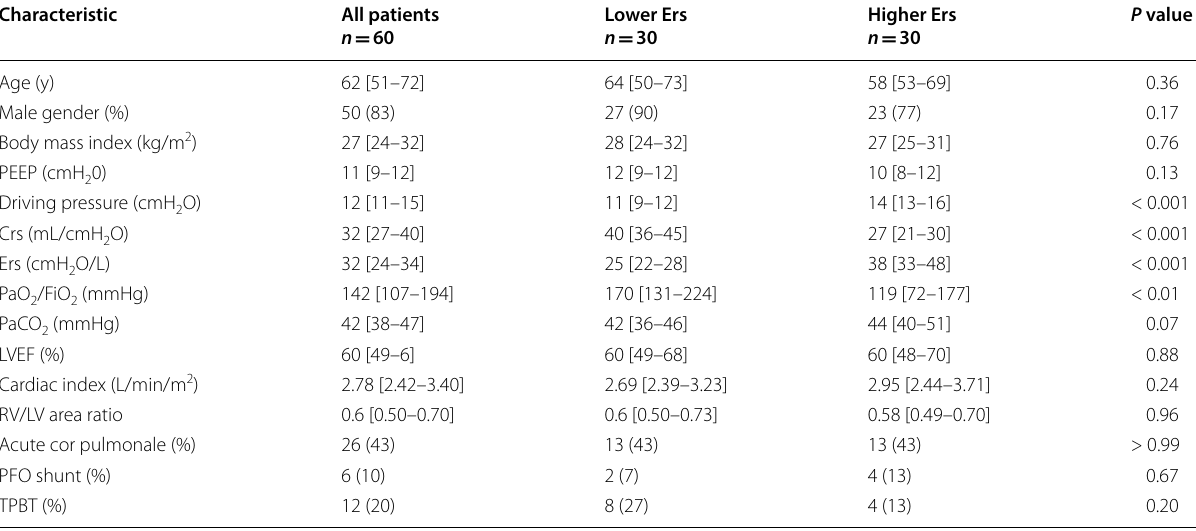
Table 1 Demographic characteristics, respiratory mechanics, and hemodynamic parameters, according to respiratory system